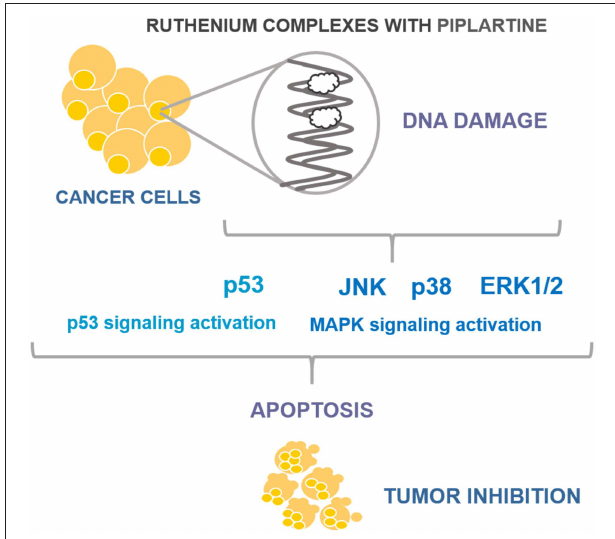
FIGURE 7 | Summary of the mechanisms of action of ruthenium complexes with piplartine in HCT116 cells.